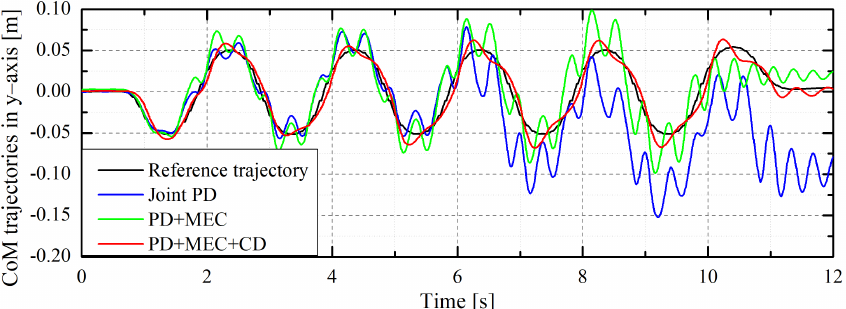
Figure 7. Comparison of the quadruped-CoM tracking results in the lateral direction ( y -axis) under the three different controllers. The black line indicates the reference lateral quadruped-CoM trajectory; the green line is the actual CoM trajectory under controller (i); the green and red lines indicate the actual CoM trajectories under controllers (ii) and